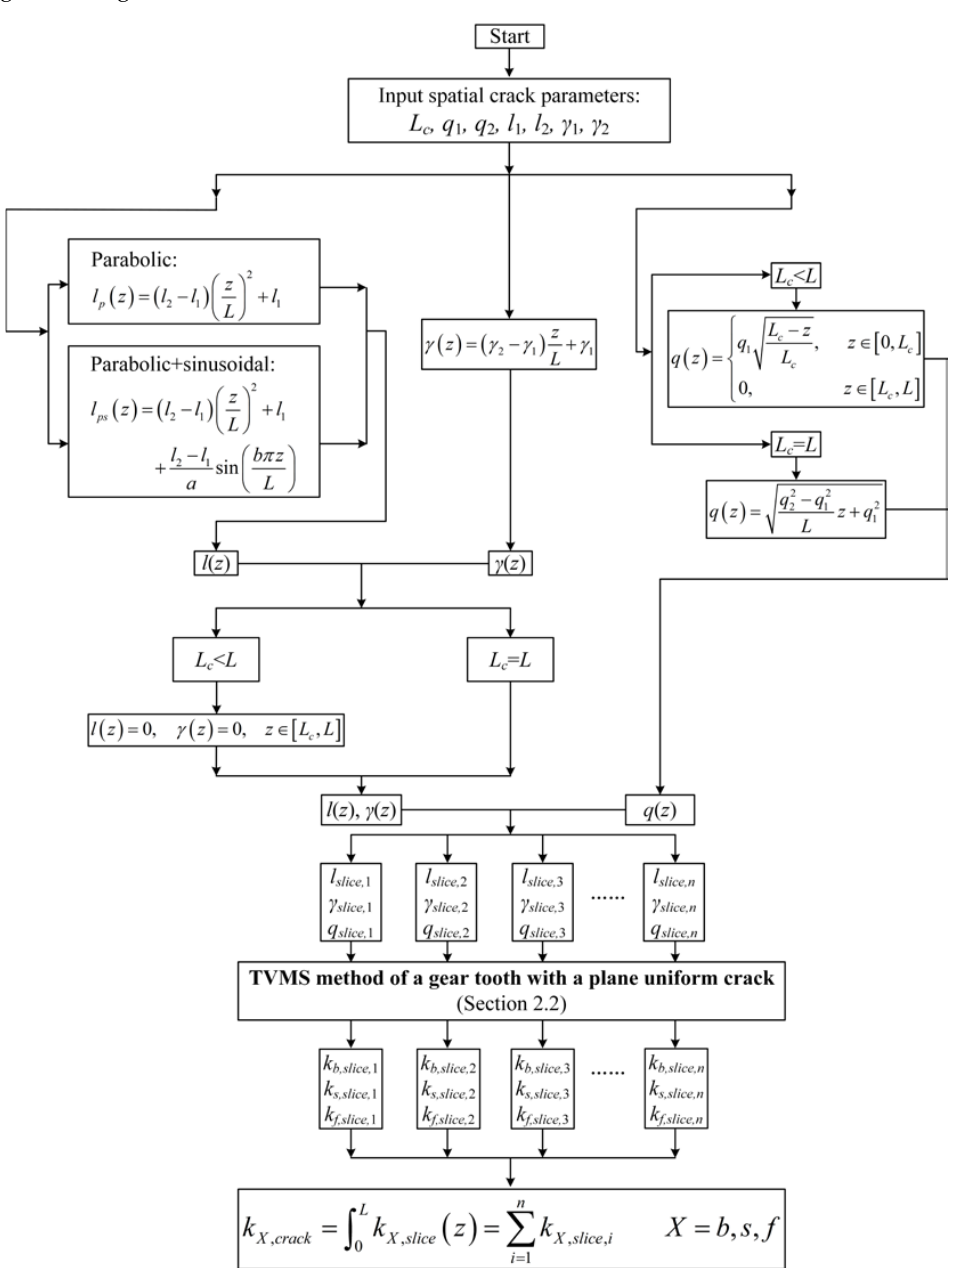
Figure 12. TVMS calculation process of a cracked spatial tooth.